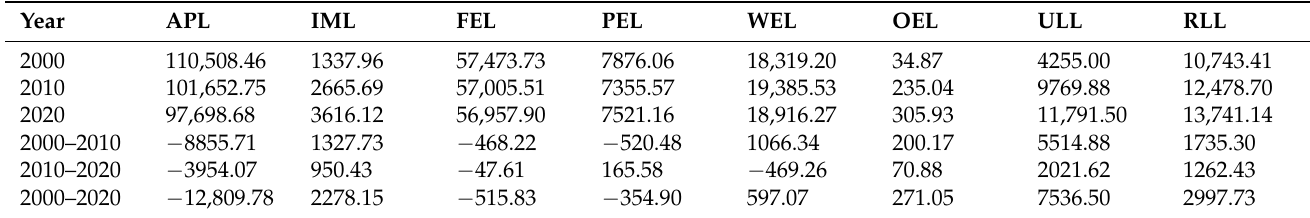
Table 2. Area of land use types in the YRDUA during 2000–2020 (km 2 ).